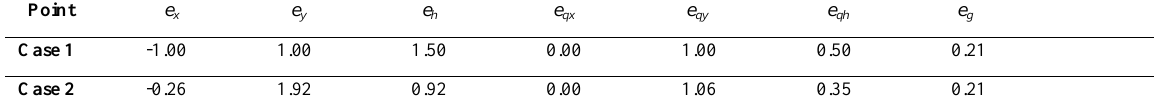
Table 1. Some coefficients of hydraulic turbine system.